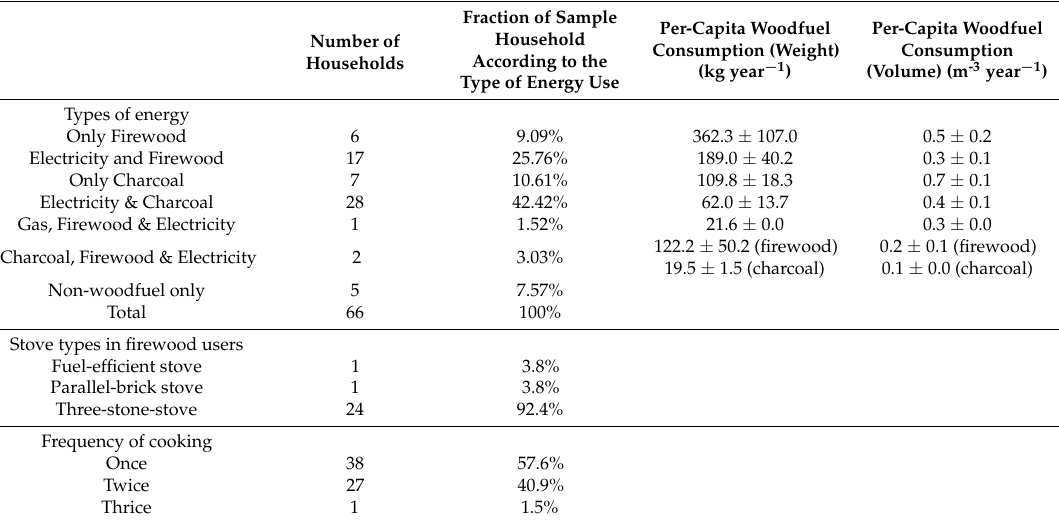
Table 2. Types of cooking energy consumed in urban area of Yedashe Township.